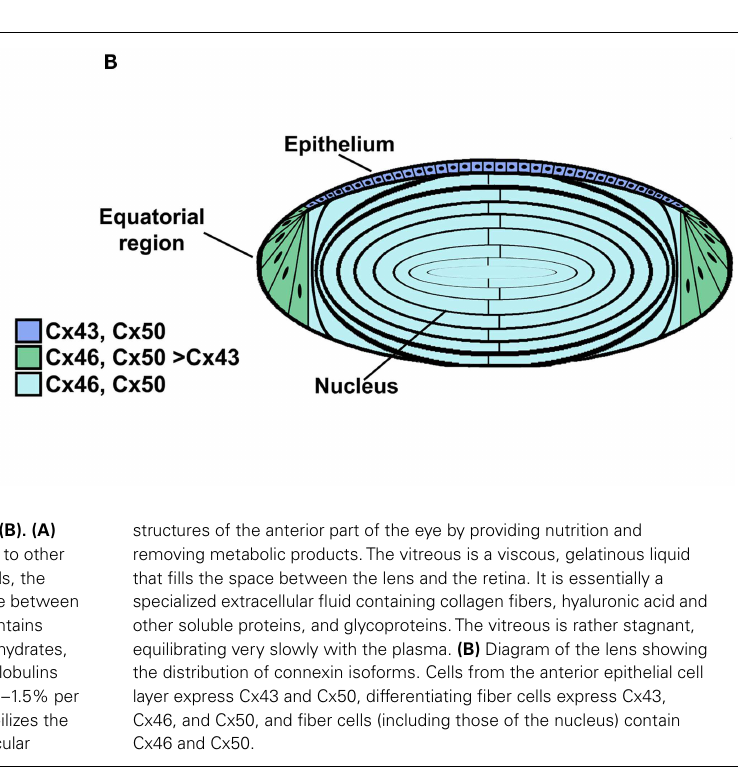
FIGURE 1 |Anatomy of the eye (A) and structure of the lens (B). (A) Diagram of the eye illustrating the location of the lens in relation to other structures.The lens is suspended between two transparent fluids, the aqueous and vitreous humors.The aqueous humor fills the space between the cornea and the lens (as well as the posterior chamber). It contains water, oxygen, carbon dioxide, inorganic and organic ions, carbohydrates, glutathione, urea, amino acids, and proteins (including immunoglobulins and growth factors) and is very dynamic (with turnover rates of 1–1.5% per minute) (reviewed by Goel et al., 2010).The aqueous humor stabilizes the ocular structure and contributes to the homeostasis of the avascular